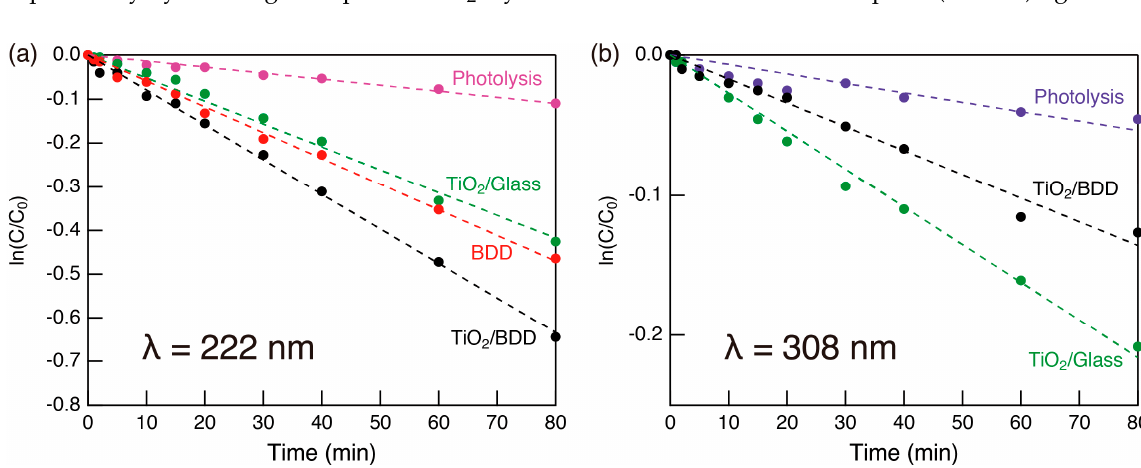
Figure 6. Time dependence of MB concentration, estimated from the visible spectra during the photocatalytic activity testing of ( a , c ) mesoporous TiO 2 /BDD and ( b , d ) mesoporous TiO 2 /glass under (a,b) 222 nm and (c,d) 308 nm UV light.